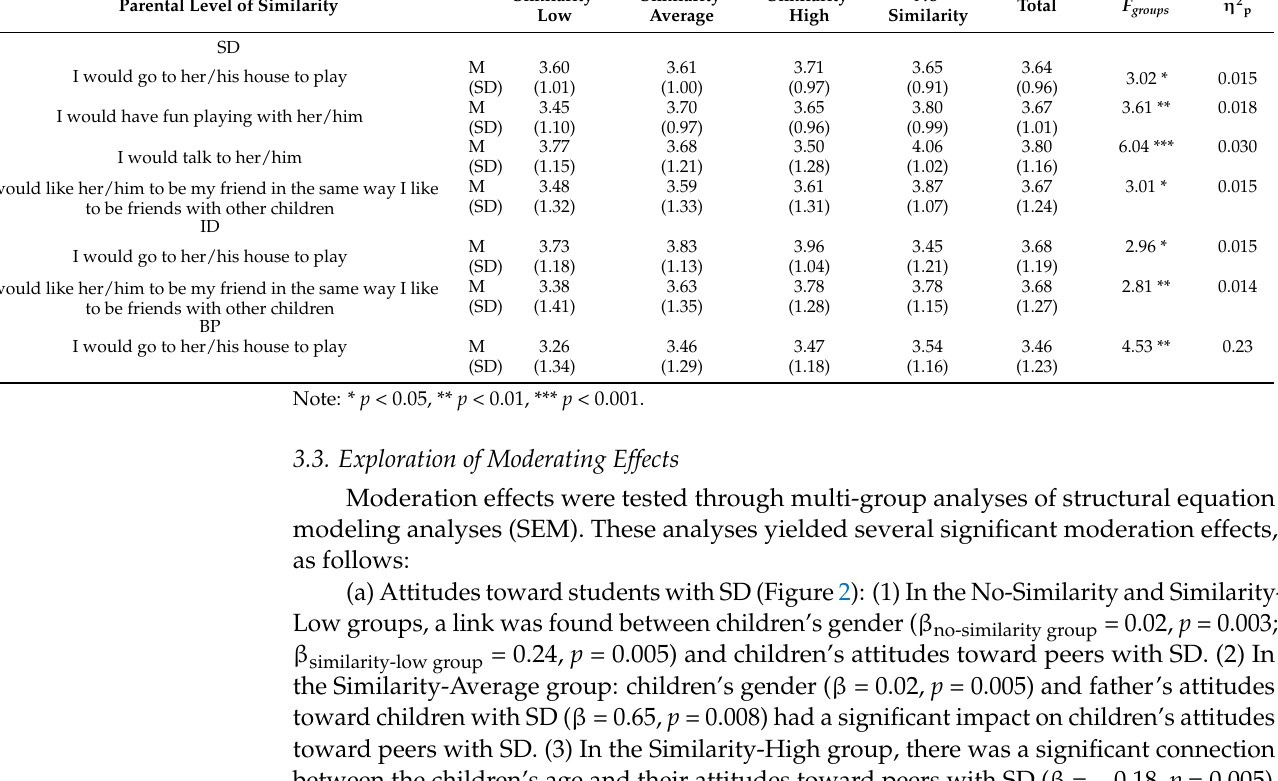
Table 6. Means, SDs, and F values for items discriminating between the types of parental similarity. Parental Level of Similarity Similarity-